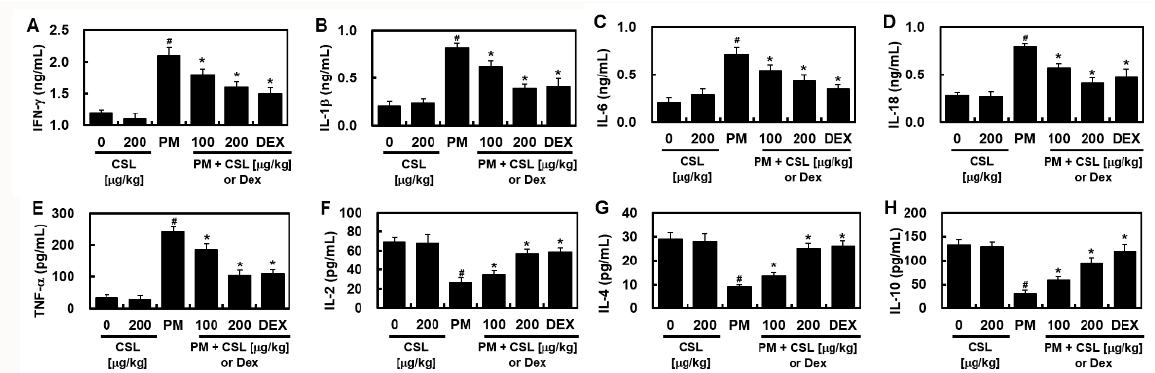
Figure 4. The effects of CSL on PM 2.5 -induced inflammatory cytokine levels. The levels of ( A ) IFN- γ, ( B ) IL-1β, ( C ) IL-6, ( D ) IL-18, ( E ) TNF-α, ( F ) IL-2, ( G ) IL-4, and ( H ) IL-10 were determined by ELISA. Values represent the mean ± SD of three independent experiments. * p < 0.01 versus the PM2.5-challenged group. # p < 0.01 versus the control group.